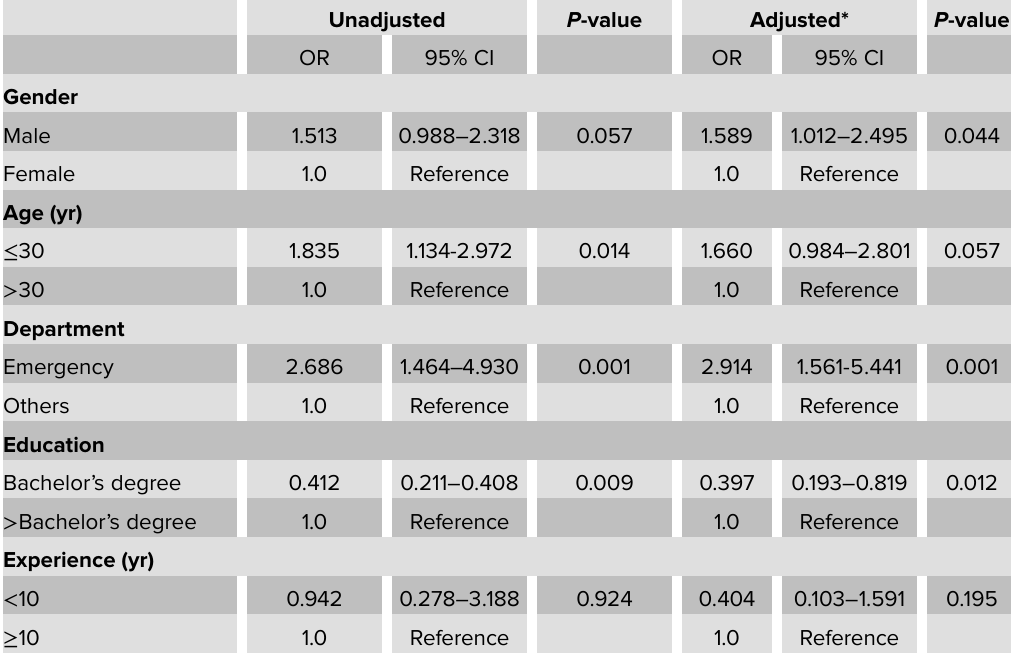
TABLE 2: Unadjusted and multivariate-adjusted odds ratios for exposure to violence among